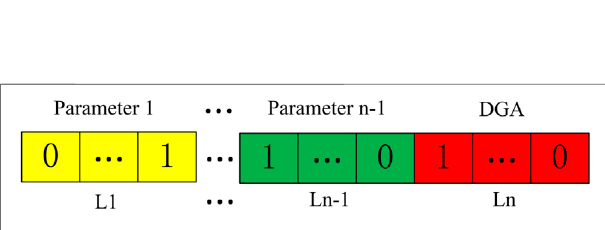
FIGURE 2 | Structure of chromosome coding. Chromosome coding contains n bit strings, of which L1 to Ln-1 represent the classi fi er ’ s parameters, and the Ln bit string represents the DGA data used for the input